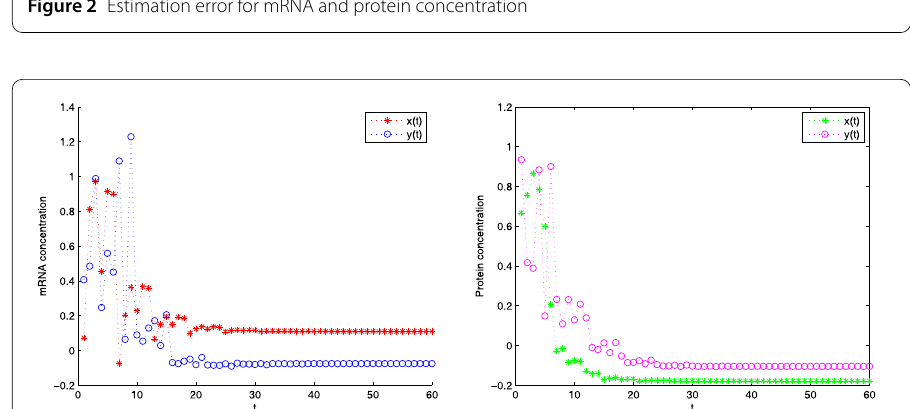
Figure 2 Estimation error for mRNA and protein concentration